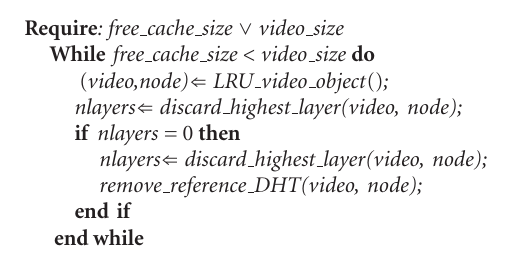
Algorithm 3: Discarding layers, the local approach.